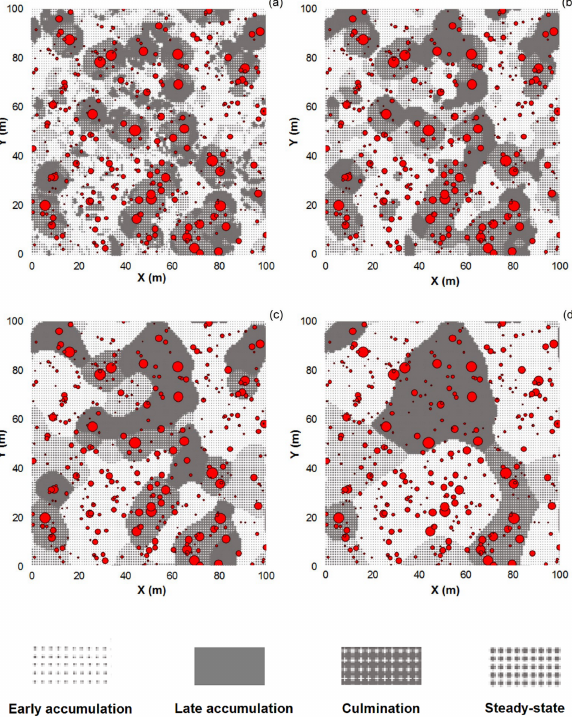
Figure 5. Effect of applying a majority filter on patch classification (example): original classification without noise smoothing ( a ) and after filtering with kernels of 3 × 3 ( b ), 5 × 5 ( c ), and 7 × 7 cells ( d ). In the classification procedure, the moving window diameter was 15 m, and the moving distance was 1 m.